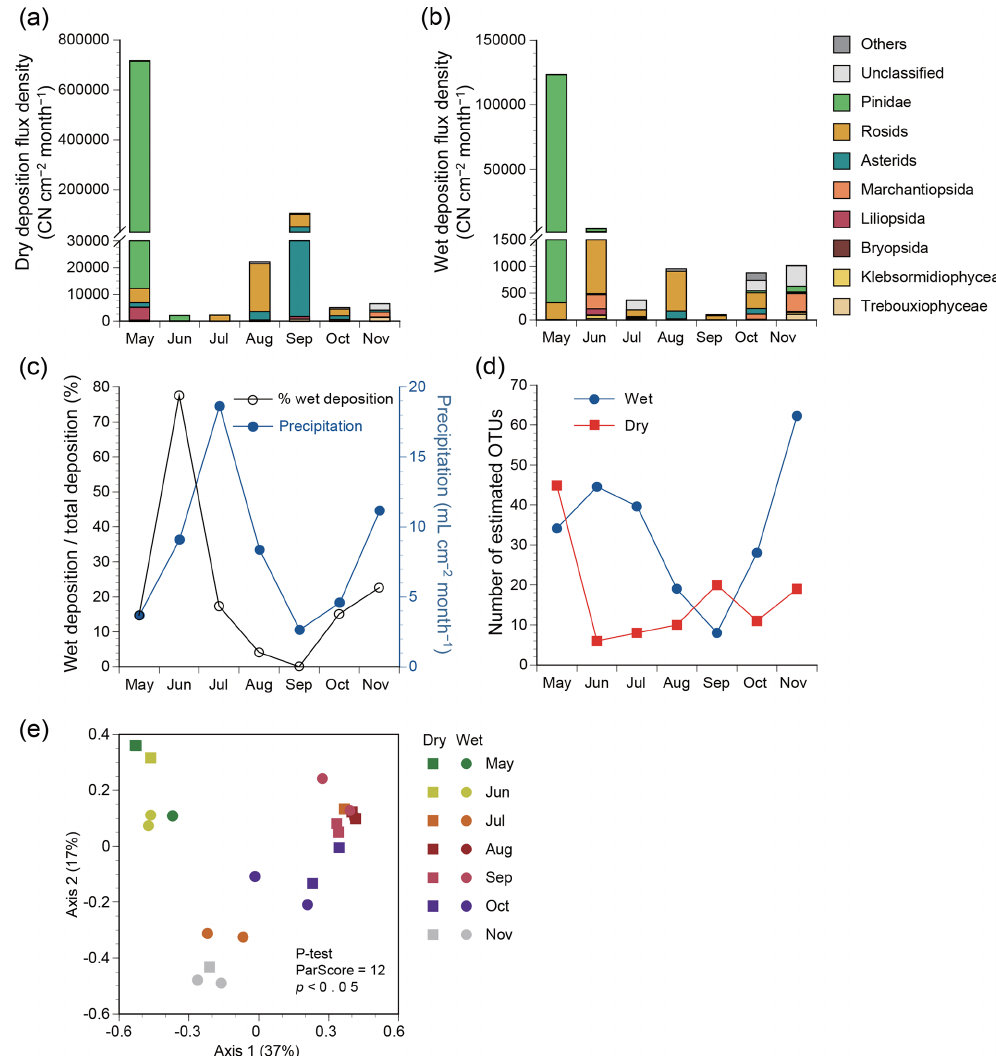
Figure 3. Deposition flux densities based on plant classes or clades in terms of copy number (CN) of ITS2 from May to November 2015 in Seoul in South Korea. (a) Dry deposition. (b) Wet deposition. (c) Precipitation and relative contributions of wet deposition to total deposition. (d) Estimated number of 97% OTUs in dry and wet deposition based on the Chao1 estimator. (e) Principal coordinate analysis plot for plant assemblage structures based on the Bray–Curtis